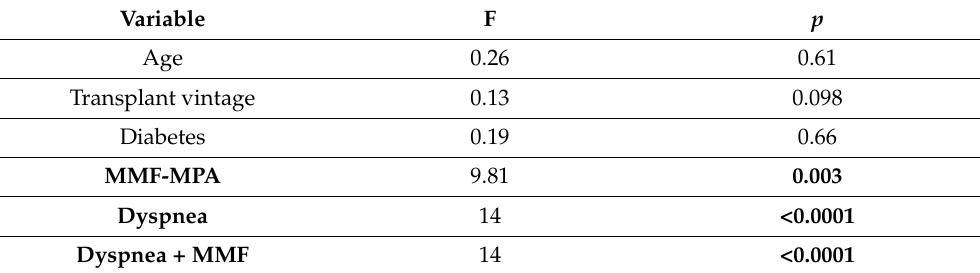
Table 3. Multivariate